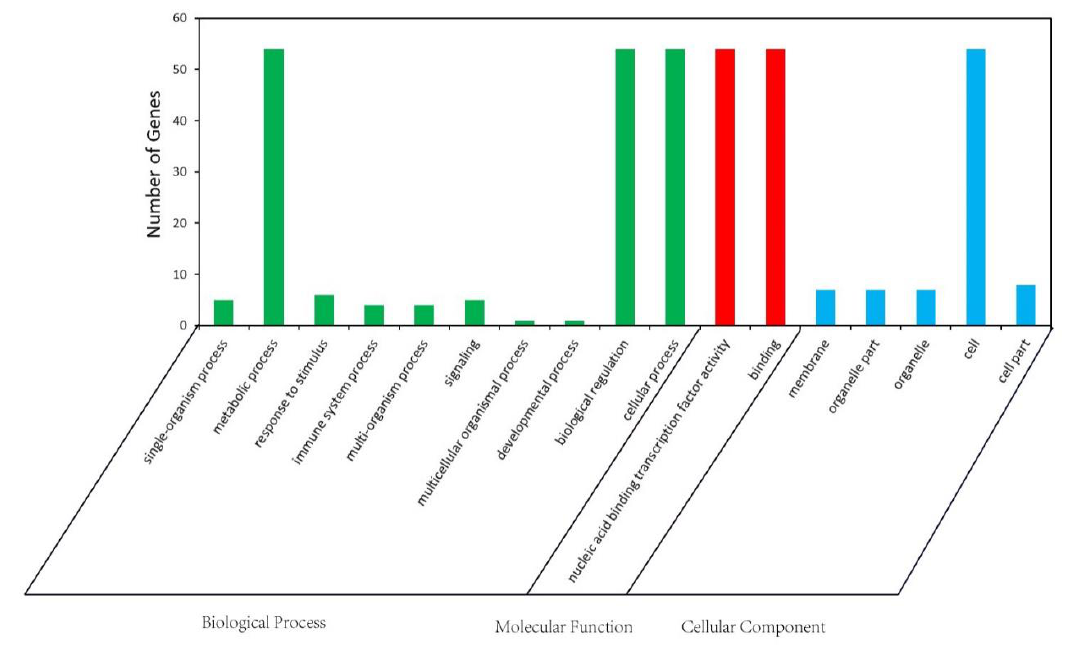
Figure 6. Gene ontology (GO) enrichment analysis of maize bZIP genes. The green, red, and blue columns represent the Biological Process, Molecular Function, and Cellular Component, respectively.